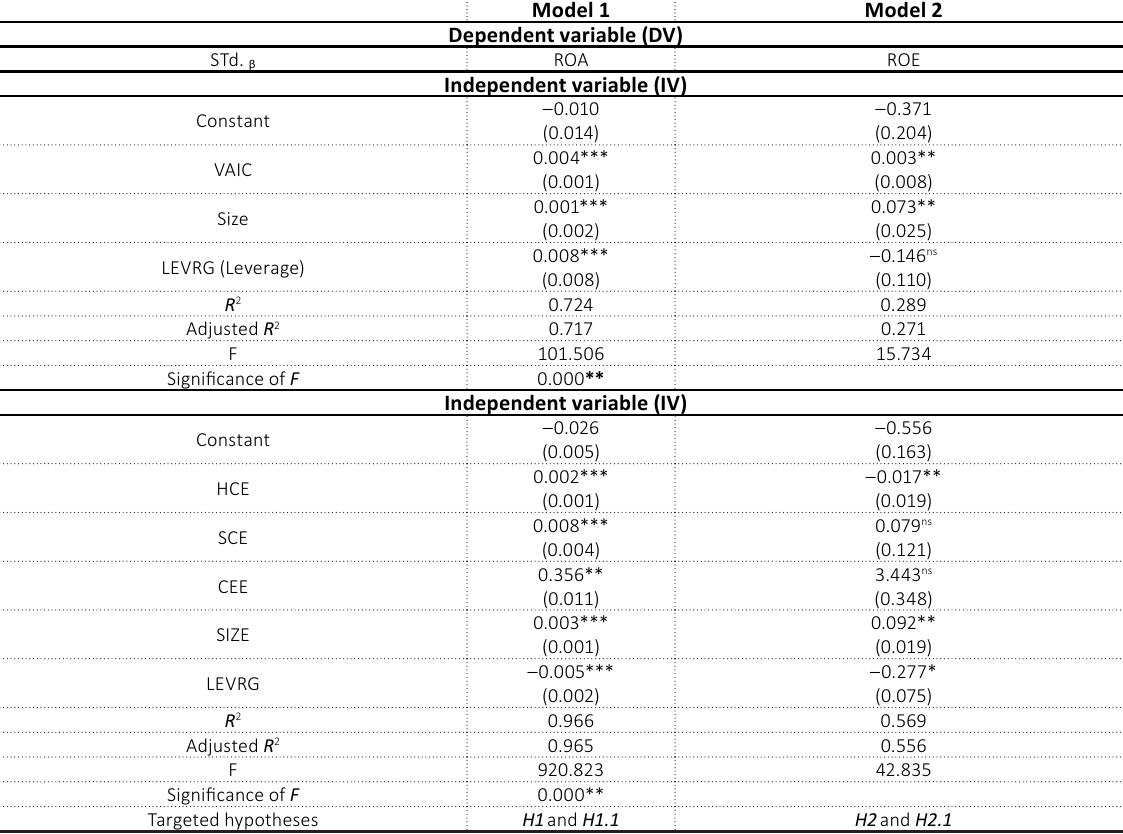
Table 2. Regression